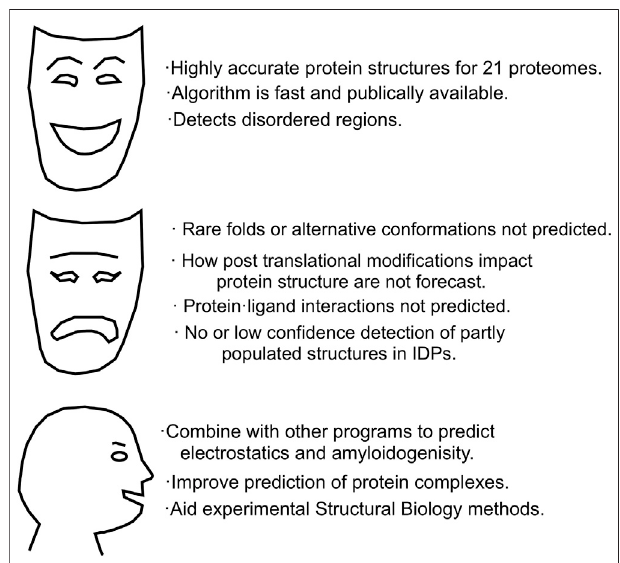
FIGURE 4 | AlphaFold 2. Strengths, weaknesses and future